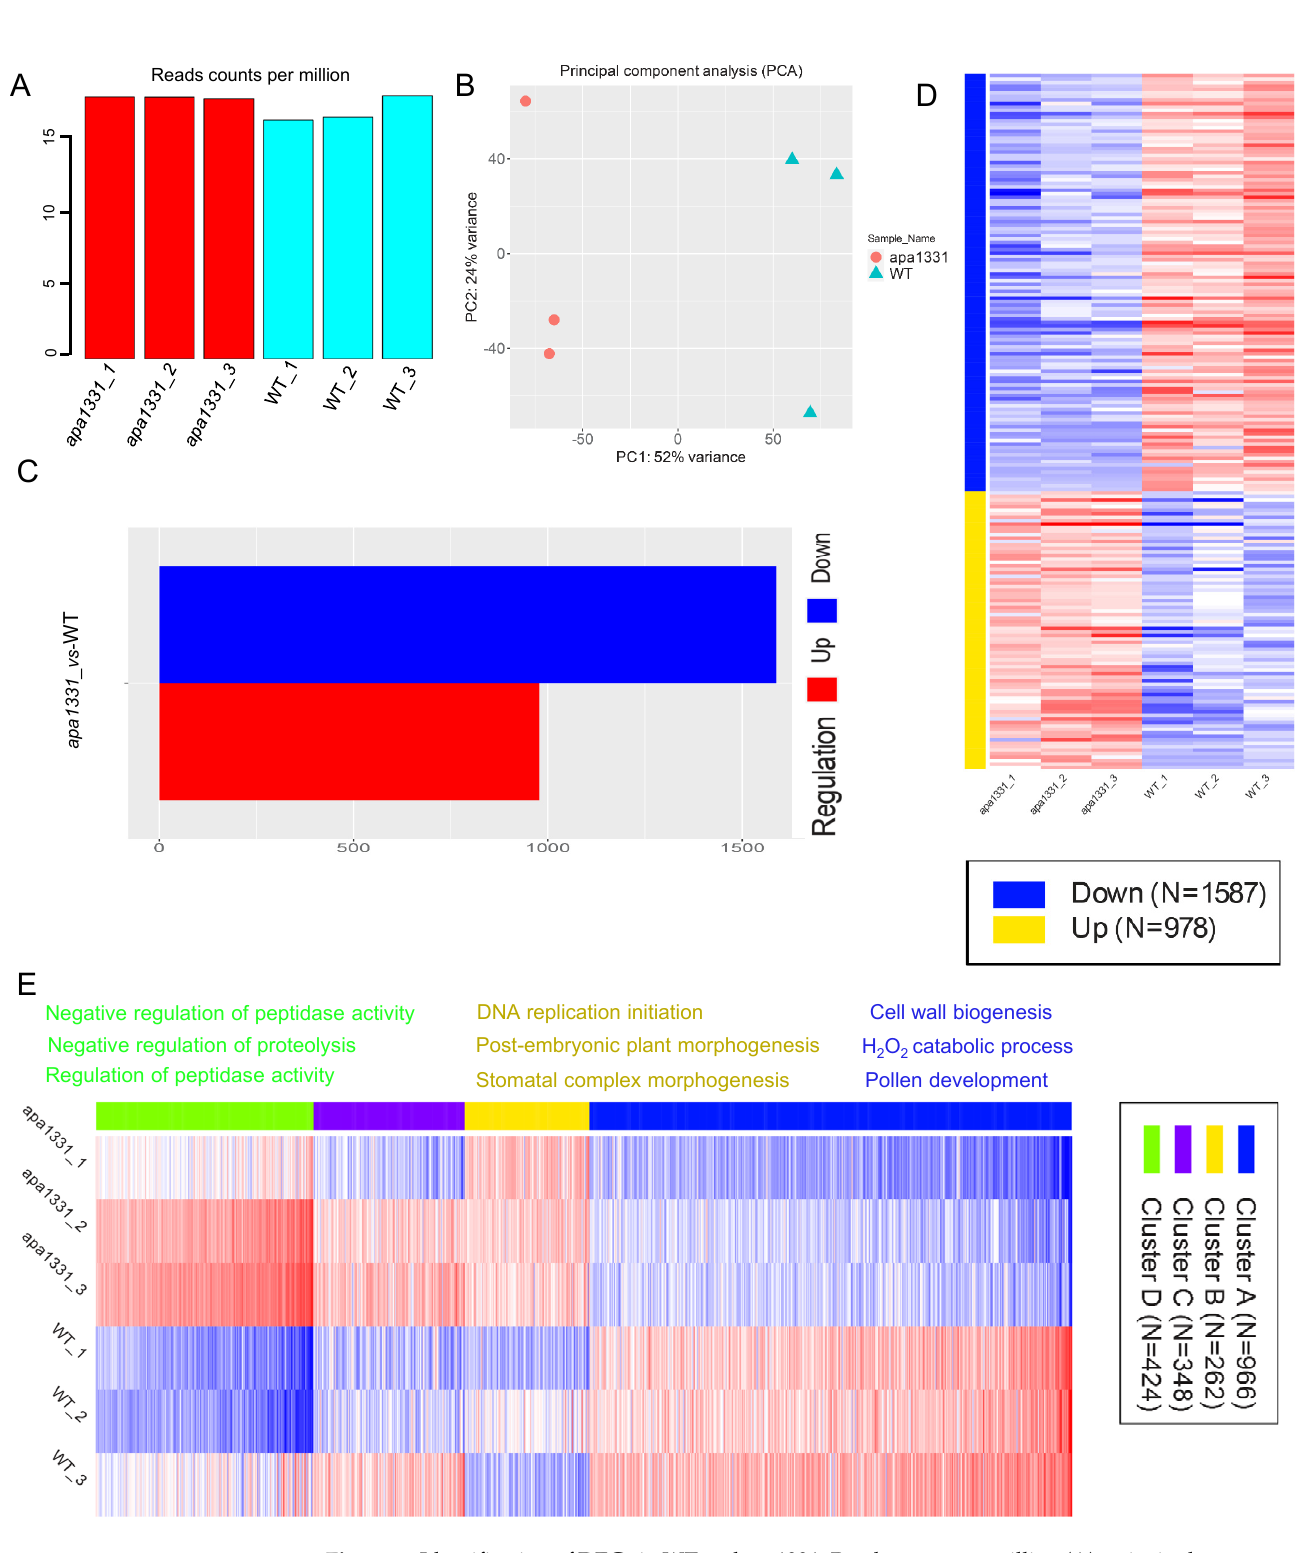
Figure 2. Identification of DEGs in WT and apa1331. Read counts per million ( A ); principal component analysis ( B ); difference between the number of up- and downregulated genes ( C ); heat map displaying the clustering analysis of DEGs in up and downregulation ( D ); heat map displaying the expression of DEGs based on k-means enrichment analysis ( E